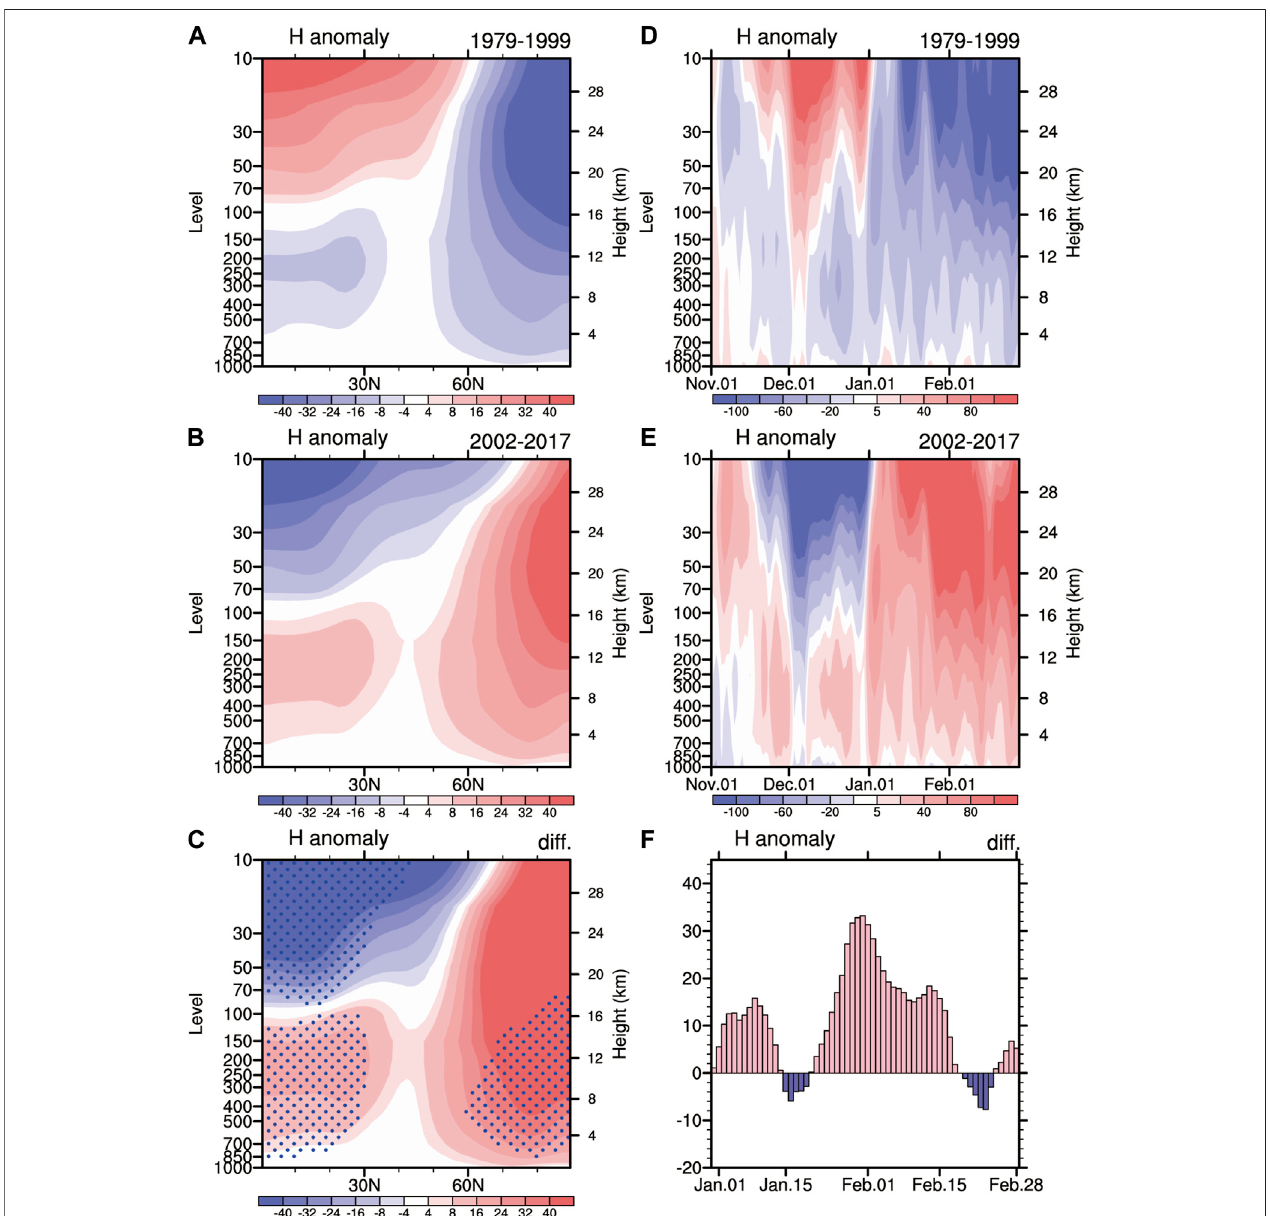
FIGURE 10 | (A, B, C) Cross-section of the geopotential height anomalies (units: gpm) averaged zonally within the North Atlantic (90 ° W – 30 ° E) during (A) 1979 – 1999and (B) 2002 – 2017, and (C) their difference (2002 – 2017minus 1979 – 1999). Anomalies arecalculatedbased ontheclimatologyof1979 – 2017.Thedotted areas in (C) indicate statistical signi fi cance at the 95% con fi dence level based on the Student ’ s t -test. (D, E) The daily evolution of geopotential height anomalies (units: gpm) averaged within the North Atlantic high-latitudes (60 ° – 90 ° N, 90 ° W – 30 ° E) during (D) 1979 – 1999 and (E) 2002 – 2017. (F) The daily evolution of geopotential height (units: gpm) difference [abs (E) minus abs (D) ] averaged vertically from 1,000 to 10 hPa.